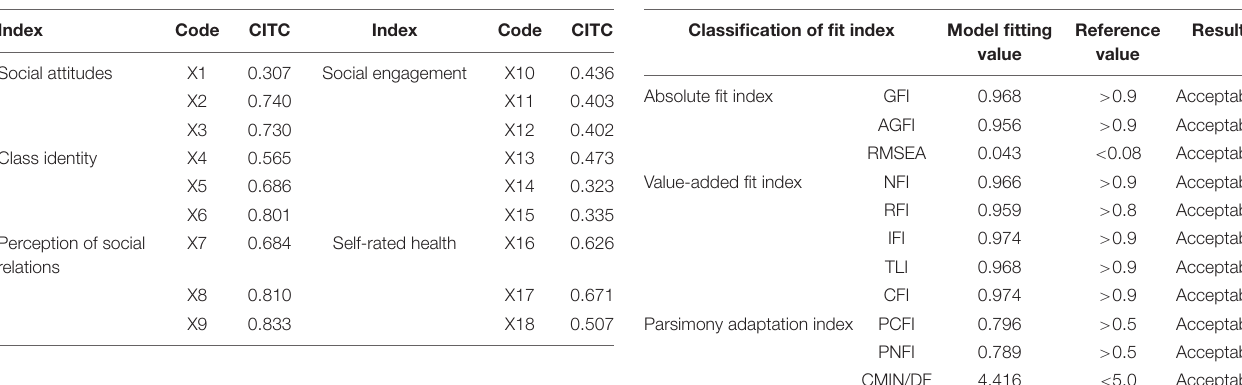
TABLE 2 | Reliability and validity tests of the variable indexes. TABLE 3 | Results of the model fitness